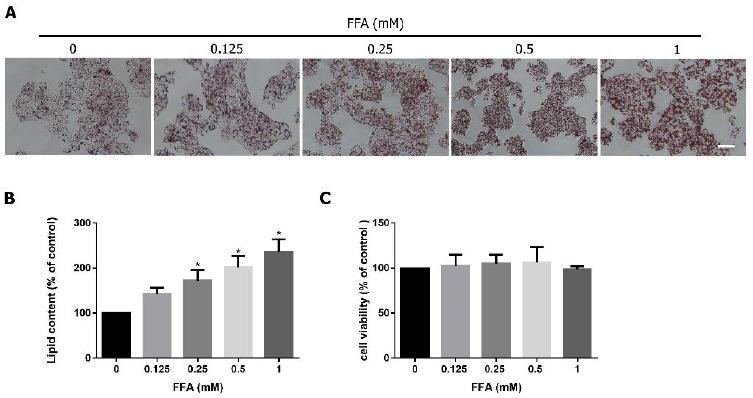
Figure 2. Effects of free fatty acids (FFAs) mixture on lipid accumulation and cytotoxicity in HepG2 cells. ( A ) Oil Red O staining. ( B ) Quantification of lipid contents. ( C ) MTT assays. The representative images are from six independent experiments. Scale bar: 50 µ m. Data were quantified for three to six independent experiments and expressed as mean ± SD. * P < 0.05 compared with the control group (0 mM).